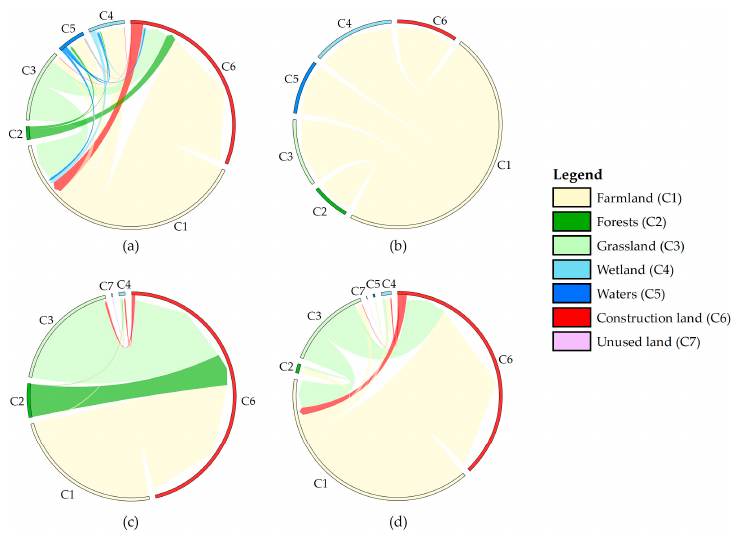
Figure 4. Transfer relationship of different land-use types in DLB from 2020 to 2030. ( a – d ) In 2020–2030NES/2020–2030EPS/2020–2030EDS/2020–2030PDS. According to Figure 4a–d: (1) In the NES (Figure 4a), the areas of farmland, forests, grassland, and unused land separately shrink by 917.25 km 2 , 84.62 km 2 , 368.83 km 2 , and 0.29 km 2 ; the areas of wetland, waters, and construction land separately increase by 150.26 km 2 , 93.52 km 2 , and 1127.21 km 2 . Construction land will expand mainly by invading farm- land, grassland, and forests, while a small amount of construction land will also be trans- formed into farmland. (2) In the EPS (Figure 4b), the area of farmland is predicted to de- crease by as much as 972.28 km 2 , the area of construction land will only increase by 195.19 km 2 , while areas of forests, grassland, wetland, and waters will increase substantially un- der stringent ecological protection policies such as returning farmland to forests and lakes. Farmland becomes the only land-use type that is transformed into others, while ecological land, including wetland, grassland, waters, and forests, will receive the largest area of transition from farmland. In the meantime, the proportion of transferred farmland ab- sorbed by construction land will plummet to 20.04%. (3) In the EDS (Figure 4c), because production and living needs are maximized such that the development of ecological land is not restricted, the decreased amplitude of the farmland area is projected to slow down; the area of construction land will enlarge as high as 1451.20 km 2 by 22.05%; the areas of forests, grassland, and unused land will maximally reduce by 169.23 km 2 , 553.25 km 2 , and 5.49 km 2 ; the area of waters is predicted to show no increase. Influenced by preferential policies for economic development, construction land invades a great deal of land, in which farmland, grassland, and forests separately account for 50.66%, 37.66%, and 11.38%. (4) In the PDS (Figure 4d), economic development, farmland protection, and ecological protection are considered at the same time in the basin, which enables a more reasonable land-use pattern to be developed. Therein, the area reduction in farmland will be 908.07 km 2 , which is only larger than that in the EDS; apart from the EPS, the forests area also shows a positive increase of 47.12 km 2 ; the area of construction land grows by 1162.84 km 2 , approaching the level in the NES. The land circulation direction in the PDS is similar to that in the NES. The difference is that the expansion of construction land does not destroy existing forests but relies on the transition of farmland and grassland. In addition, the area of construction land transformed into farmland is predicted to decrease by 52.03%.